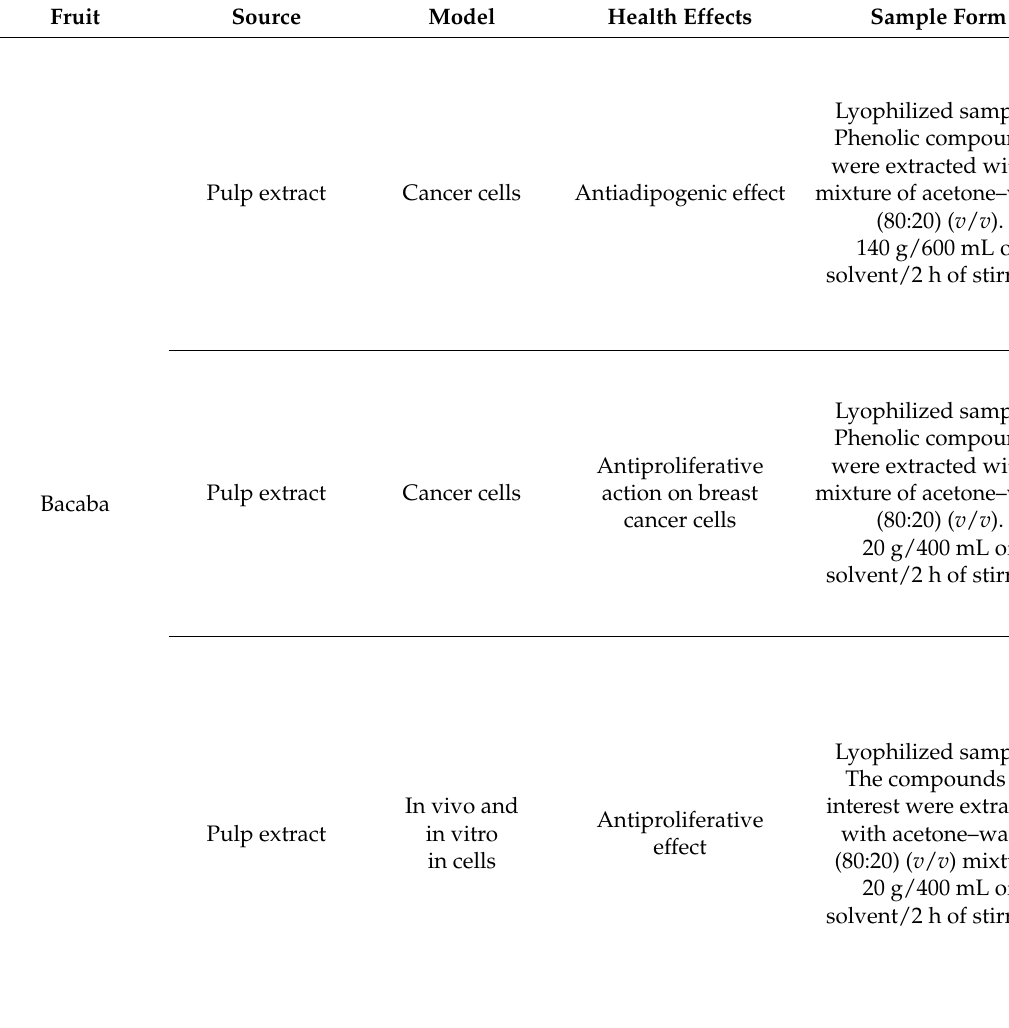
Table 5. Effects on health for bioactive compounds extracted from fruits of the Arecaceae